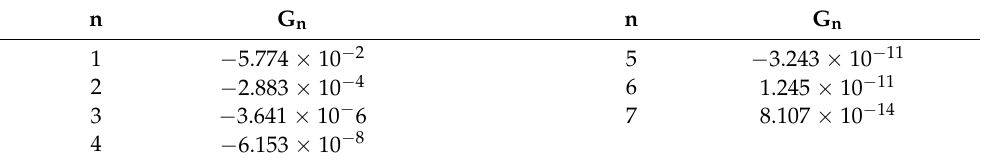
Table A15. Coefficients of the H 2 O-LiBr + LiNO 3 enthalpy equation.